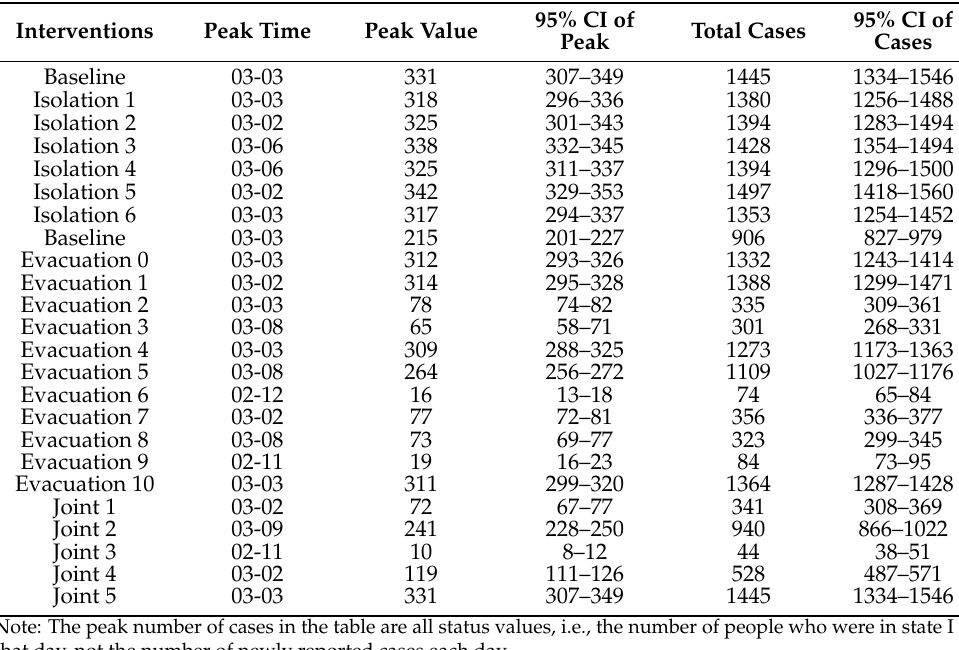
Table 2. The prevalence of infectious diseases in different scenarios.